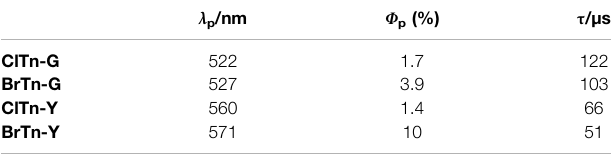
TABLE 2 | Phosphorescence maxima, quantum yields, and lifetimes.